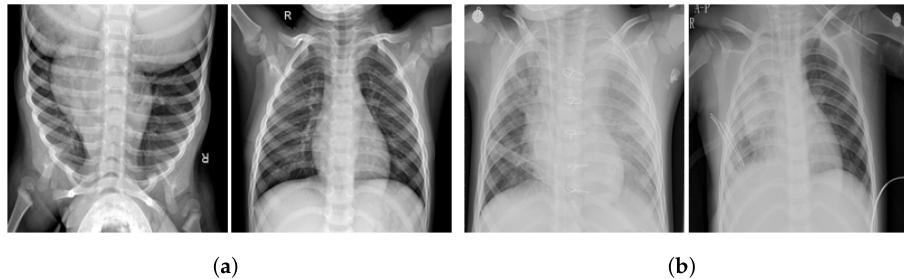
Figure 2. Samples of CXR images. ( a ) Normal and ( b )